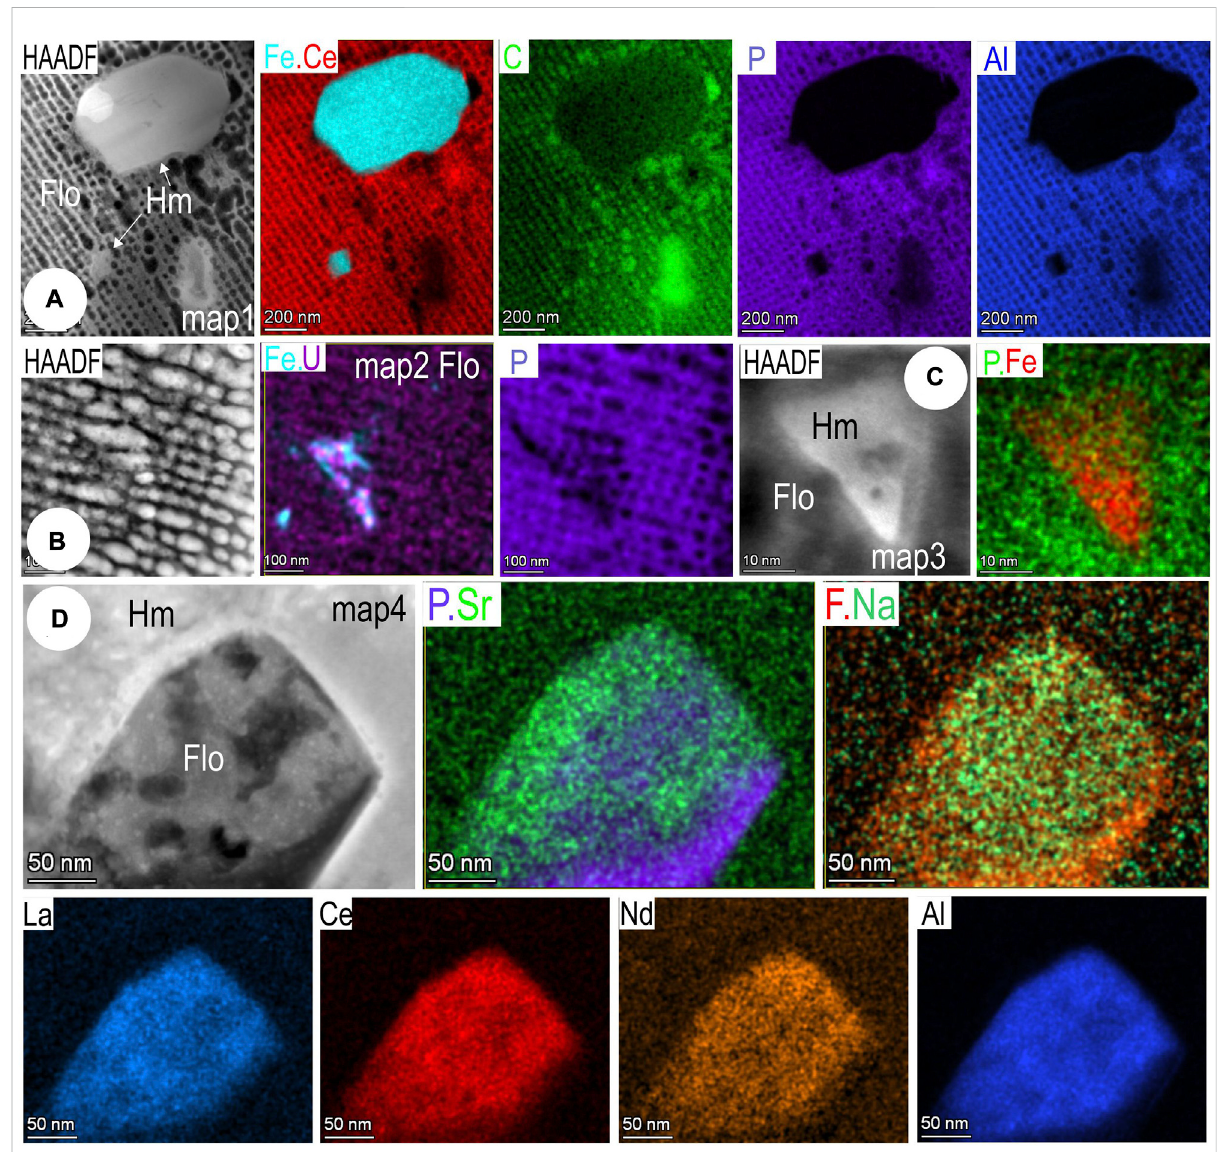
FIGURE 14 Images and STEM EDS element maps of fl orencite (Flo) from sample 10OD (foil Hm#3). (A) Hematite (Hm) inclusions in coarse fl orencite with “ holey ” texture. This corresponds to the conspicuous pattern visible on the C map. (B) Heterogeneity in fl orencite from (A) mapped as Fe and U. (C) Hematite NP mapped in fl orencite. (D) Zonation patterns (distribution of P, Sr, F, and Na) in one of the fl orencite fi ne particles.